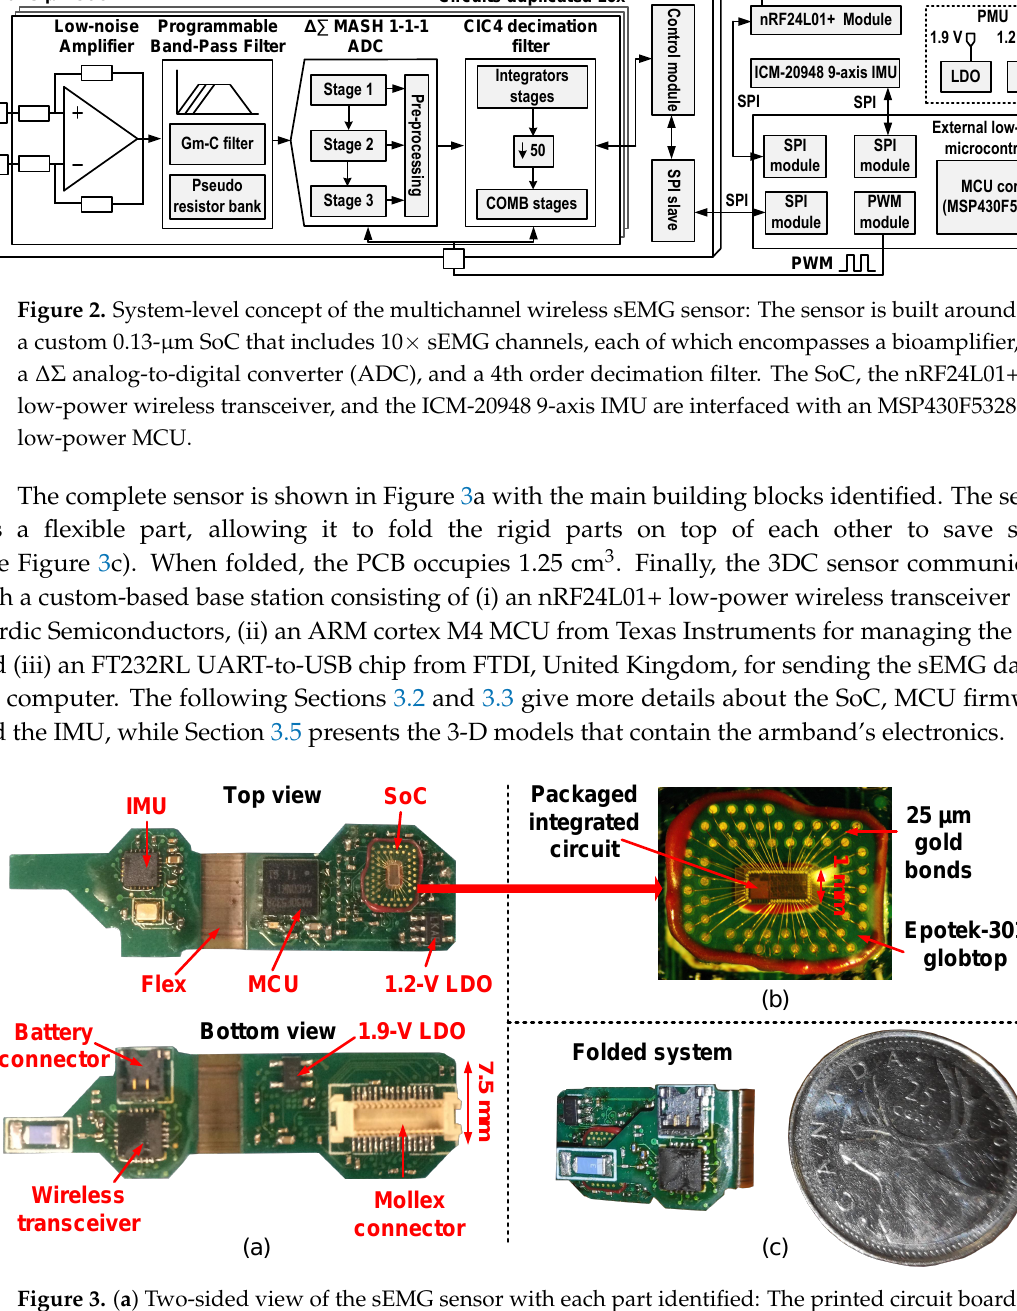
Figure 3. ( a ) Two-sided view of the sEMG sensor with each part identified: The printed circuit board (PCB) has a flexible region to fold the two rigid parts on top of each other to save space. ( b ) The packaged SoC which is wirebonded directly on a PCB substrate. ( c ) The system folded in its final position beside a Canadian quarter coin (diameter of 23.88